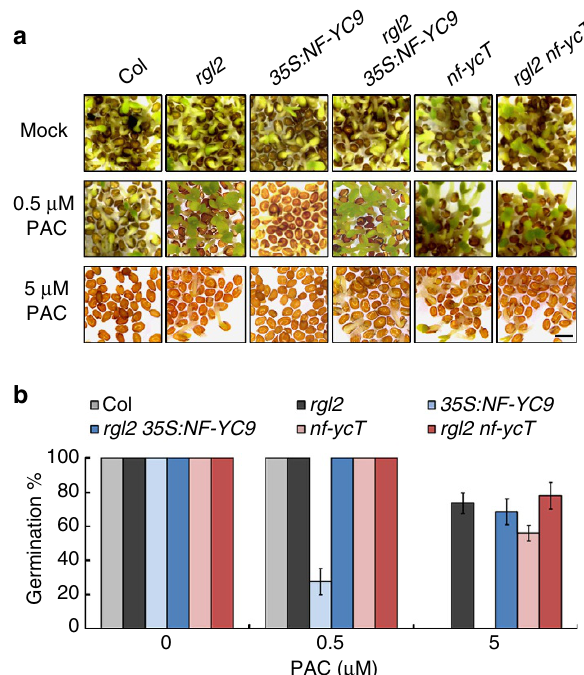
Figure 3 | RGL2 compromises the PAC hypersensitivity of NF-YC9 overexpression line in seed germination. ( a ) Germination phenotypes of rgl2 , 35S:NF-YC9 , rgl2 35S:NF-YC9 , nf-ycT , rgl2 nf-ycT and the wild-type (Col) seeds observed at 96 HAS on 1/2 MS medium containing different concentrations of PAC. Scale bar, 1mm. ( b ) Statistic analysis of germination rate in the seeds described in a . Data represent mean ± s.d. of at least 100